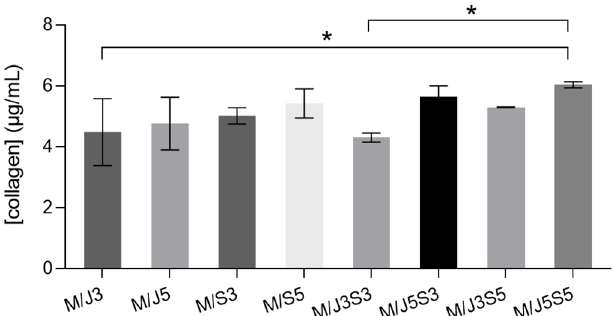
Figure 2. Quantification of total collagen concentration on developed membranes (M/J3 to M/J5S5). Data bars are mean ± standard error (n = 3). Comparative statistical analysis was performed, where systems M/J3, MJ3S3 and M//J5S5 include statistical significance of p < 0.05 (*), and ns (no significant) for the rest of systems.